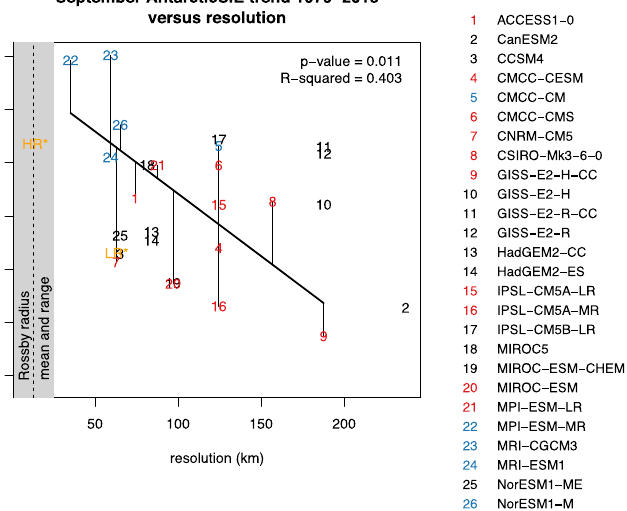
Fig. 1 September Antarctic sea-ice extent (SIE) trends during the satellite era (1979 – 2018) in current climate models participating in the Coupled Model Intercomparison Project (CMIP5). a Trends in SIE as function of mean SIE. The grey box encompasses CMIP5 models that are close to the observed mean September SIE (OBS 97 , vertical dashed line) within ±3 million km 2 . Those models with positive or only moderate negative linear trend (within ±0.3 million km 2 per decade of the observed trend, horizontal dashed line) are coloured blue, the other models with stronger negative trends are coloured red. Numbers represent CMIP5 models listed to the right. b , Trends in SIE as function of average ocean resolution in the Southern Ocean (45 – 65° S latitudinal band). The vertical dashed line denotes the mean Rossby radius of deformation in that band (13 km), while the grey box de fi nes its range. For the models with good representation of mean SIE, a linear relationship between trend and ocean resolution is evident, with slope signi fi cantly different from zero at the 5% level ( p = 0.011). The average ocean resolution was computed for each of the CMIP5 models as the square root of the average grid cell area of all ocean model cells located in that band, according to their centre (see “ Methods ” ). Only ensemble means are given for each CMIP5 model (an otherwise identical fi gure with all ensemble members is provided in Supplementary Figs. 2 and 3). HR* and LR* (orange) are results from the two high- and low-resolution AWI-CM simulations discussed in this paper, but for the later period 2019 – 2058. High-resolution SIE decrease is delayed compared to the low-resolution con fi guration (see “ Methods ” for a discussion of earlier trends, including 1979 –